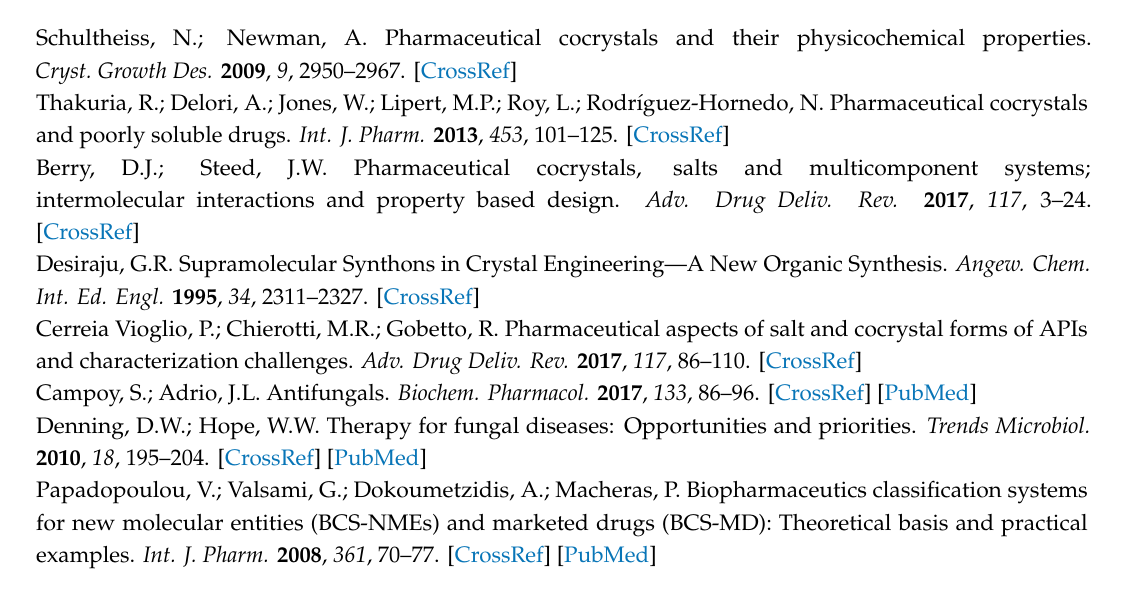
Figure S1: ( a ) PXRD patterns of itraconazole (ITR) and oxalic acid (OXA) starting material powders and the ITR–OXA cocrystal produced by ball milling (BM). * Indicates distinct peaks of the cocrystal. ( b ) DSC thermograms of ITR and OXA starting material powders and the ITR–OXA cocrystal, Figure S2: ( a ) PXRD patterns of the itraconazole (ITR) and succinic acid (SUC) starting material powders and the ITR–SUC cocrystal produced by ball milling (BM). * Indicates distinct peaks of the cocrystal. ( b ) DSC thermograms of the ITR and SUC starting material powders and the ITR–SUC cocrystal, Figure S3: Scanning electron micrographs of ( a ) the ITR–SUC cocrystal and ( b ) ITR–OXA cocrystal produced by ball milling; ( c ) freeze dried ITR, Figure S4: ( a ) PXRD pattern of freeze dried itraconazole (ITR FD) and ( b ) DSC thermogram of freeze dried itraconazole (ITR FD), Table S1: Crystal data and structure refinement for the ITR–TER cocrystal, Table S2: Hydrogen bonds for ITR–TER cocrystal [Å and ◦ ]. Crystallographic data, deposition number 2015894, were deposited with the Cambridge Crystallographic Data Centre. These data can be obtained free of charge from the Cambridge Crystallographic Data Centre via www.ccdc.cam.ac.uk /